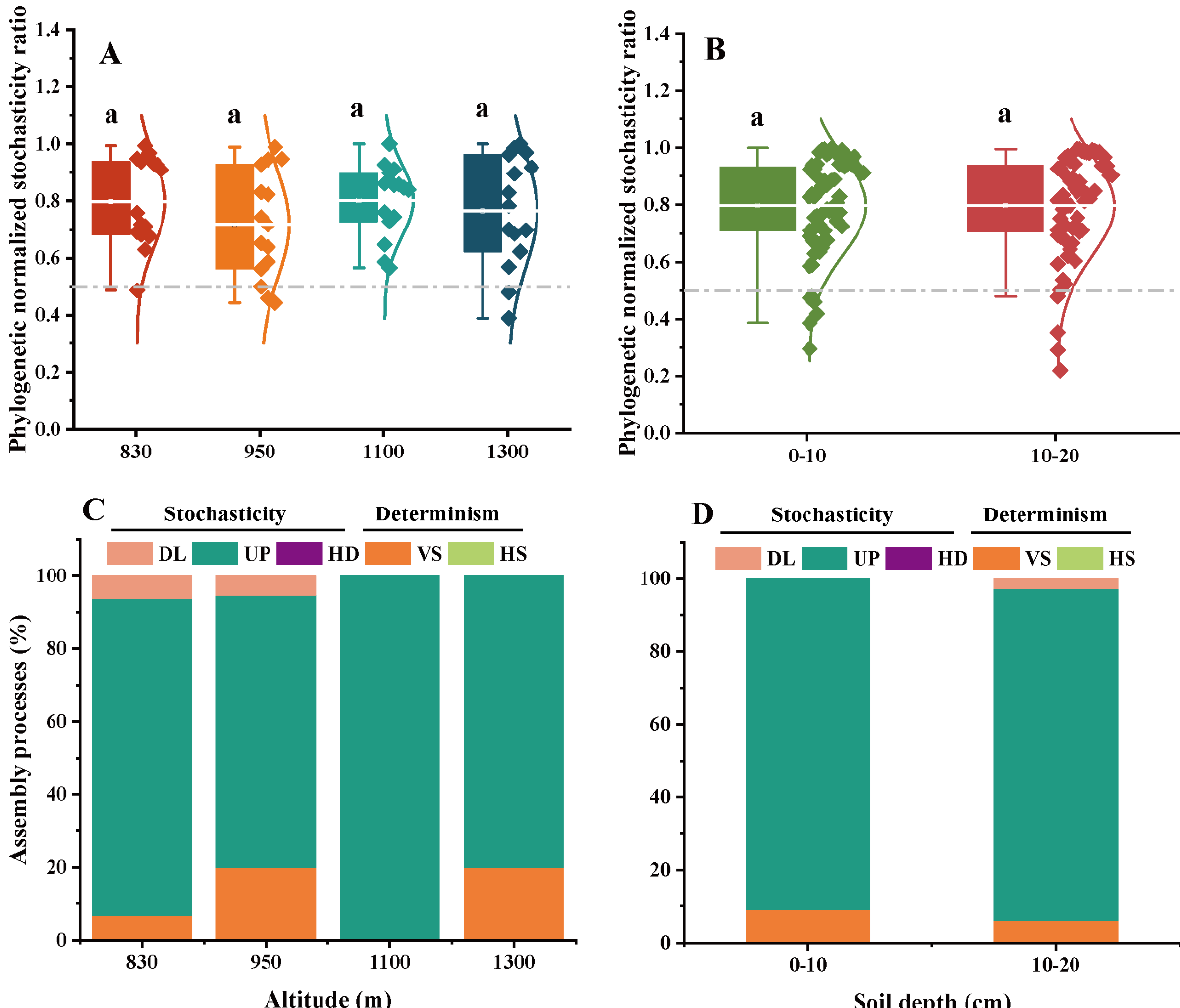
Figure 4. The ecological stochasticity in the potential EcM fungal community assembly is evaluated by the phylogenetic normalized stochasticity ratio (pNST). ( A ) Ecological stochasticity among dif- ferent altitudes; ( B ) ecological stochasticity between different soil layers. The values < 0.5 and >0.5 represent the deterministic and stochastic assembly, respectively. The relative contributions (%) of the community assembly processes in shaping EcM fungal communities at different altitudes ( C ) and soil layers ( D ). Different lowercase letters denote significant differences at different altitudes (or different soil layers) ( p < 0.05). Differences between the 0–10 cm and 10–20 cm soil layers were examined using a Student’s T -test. Differences among different altitudes were examined using Tukey’s HSD test. HS, homogeneous selection; VS, variable selection; HD, homogenizing dispersal; UP, undominated process; DL, dispersal limitation.